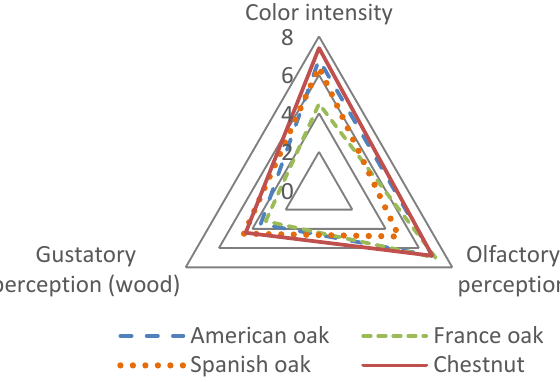
Figure 4. Color intensity, gustatory perception (wood) and olfactory perception impressions in the sensorial analysis of distillates aged in American oak, France oak, Spanish oak and Chestnut.